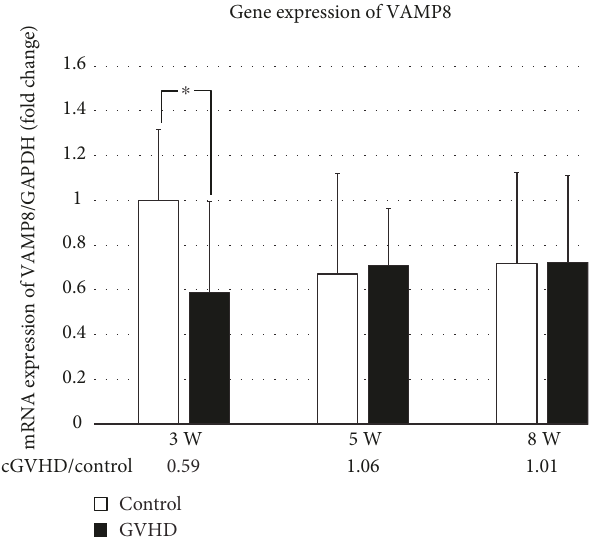
Figure 5: Time course of changes in VAMP8 gene expressions in the lacrimal gland of murine model of cGVHD. The organ was collected from the mice which underwent allogeneic or syngeneic bone marrow transplantation (BMT). The transcript levels of VAMP8 were measured by quantitative real-time PCR 3, 5, and 8 weeks after BMT. (Allogeneic group: N = 8 − 9 ; syngeneic control group: N = 8 ). In this analysis, GAPDH was used as an internal control. Bar=mean ± SD. ∗ p = 0 036 . Data from three independent